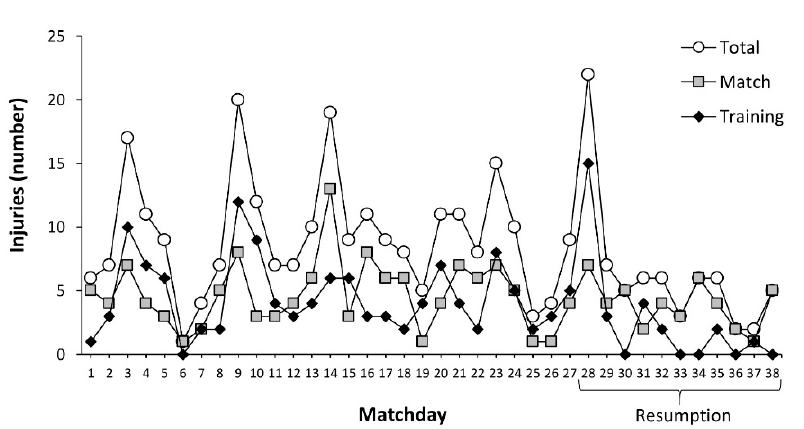
Figure 1. Number of injuries per matchday in professional football players before the suspension of LaLiga due to the COVID-19 pandemic and after the resumption of the competition. Table 2 contains the distribution of injuries before suspension and after the resumption of the competition according to tissue affected, body location, mode of onset, presence of contact, condition, recurrency, severity, and position in the field of the player. Table 2. Conditions of injury in professional football players for the matchdays performed before the suspension of LaLiga due to the COVID-19 pandemic and after the resumption of the competition. p